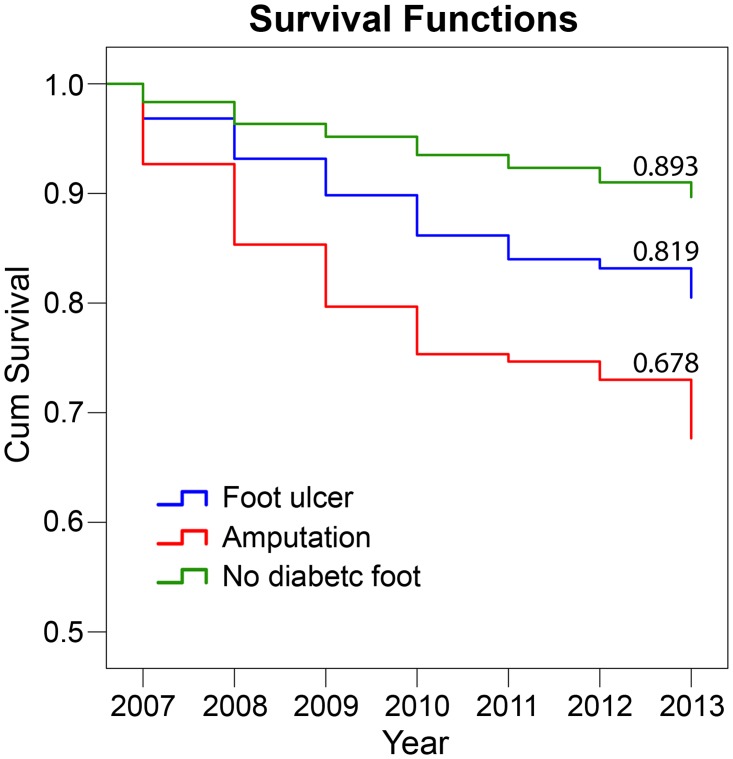
Cumulative Kaplan–Meier survival curves for diabetic patients with or without foot complications.Footnote: P value between patients with diabetic foot ulcer (DFU) and diabetic patients without foot complications is < 0.001. P value between patients with lower extremities amputation (LEA) and diabetic patients without foot complications is < 0.001.